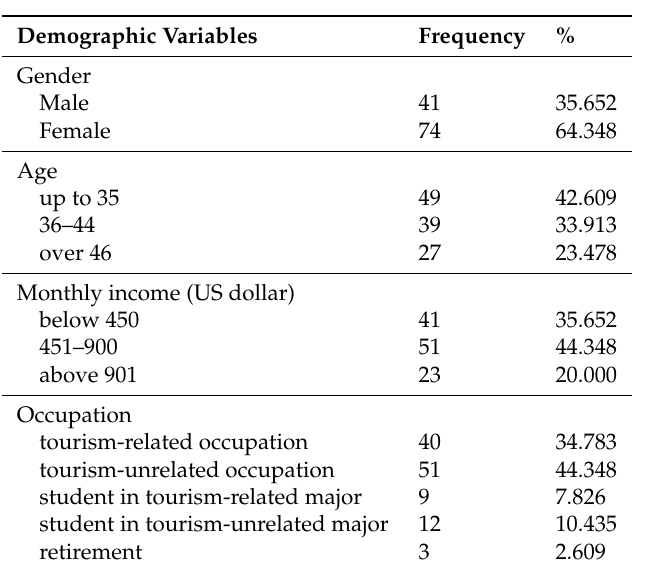
Table 3. Demographic of the sample ( n =